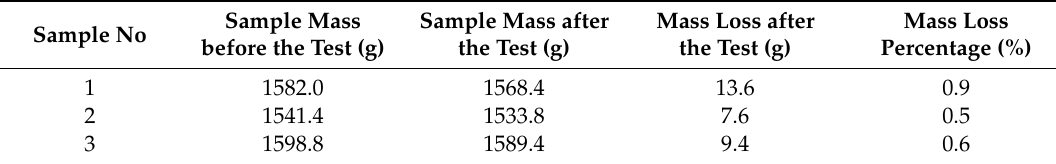
Table 6. Mass loss calculations following the flame test.